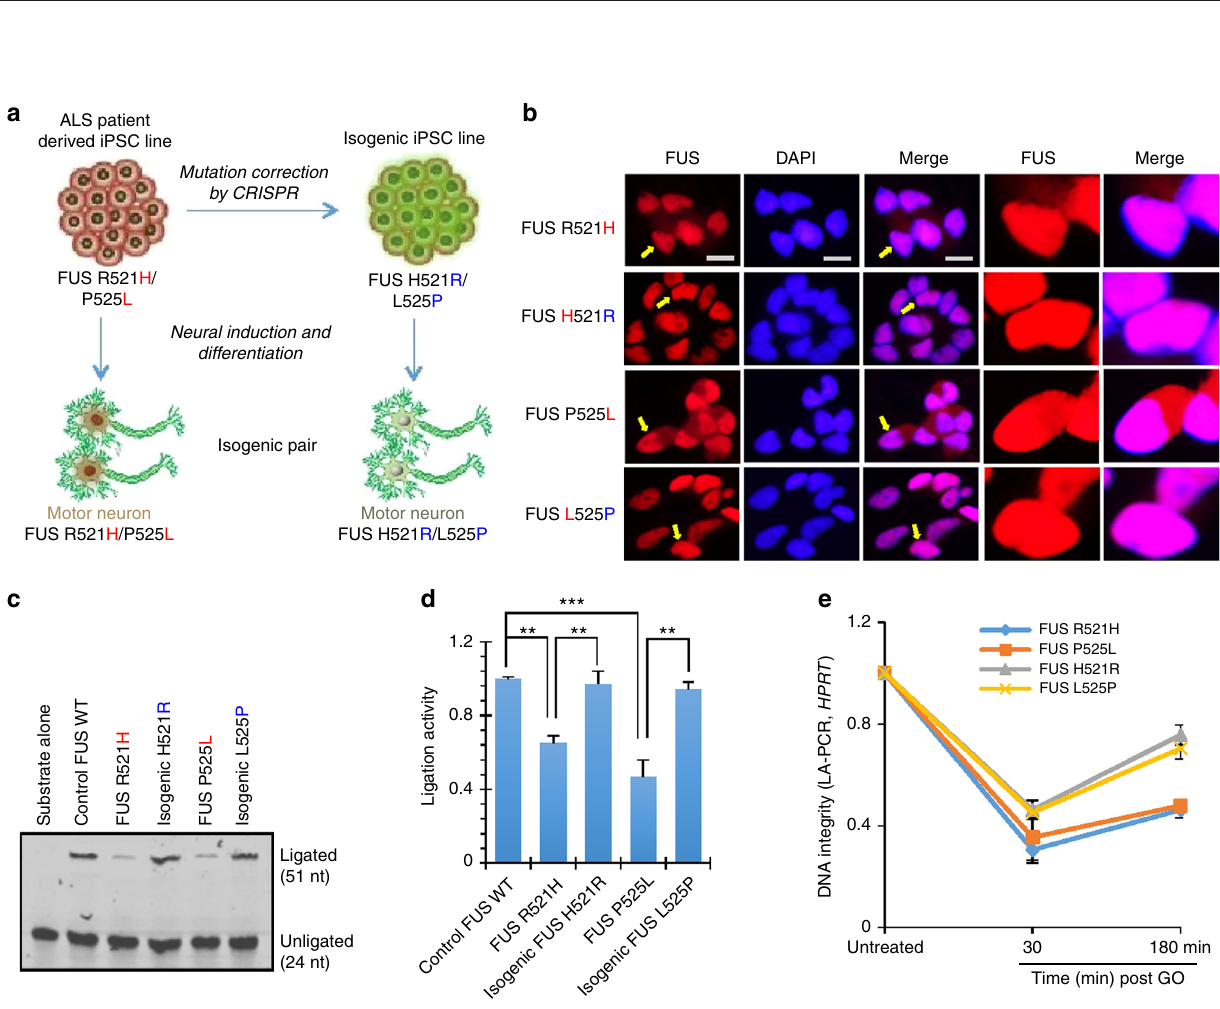
Fig. 5 Defective DNA repair in ALS patient-derived iPSC line. a The location of familial FUS mutations R521H and P525L indicated in FUS protein sequence. b , c IB of nuclear and cytosolic extracts isolated from ALS patient-derived fi broblasts, probed for FUS. H2AXII and β -actin were probed as loading control. Histogram shows quantitation of IB band intensity. The error bars are standard deviation of experiments performed in triplicate (* p < 0.05, two-tailed unpaired Student ’ s t -test). d , e Integrity of genomic DNA isolated from ALS patient-derived fi broblasts measured by long amplicon quantitative PCR (LA- PCR) analysis. 10.4 kb fragment including exons 2 – 5 of the hprt gene was ampli fi ed and separated in 1% agarose gel. The ampli fi ed DNA product was quanti fi ed using pico green fl uorescence. The error bars are standard deviation of experiments performed in triplicate (** p < 0.01, two-tailed unpaired Student ’ s t -test). f IF motor neurons for FUS to analyze its nucleus vs. cytosolic distribution. Nuclei stained with DAPI. Zoomed images on right showing FUS distribution in arrow indicated nuclear. Scale bar = 10 µ m. g , h LA-PCR-based DNA damage repair kinetic analysis. Genome DNA extracted from iPSC- derived motor neurons at indicated time points after release from exposure to GO (100 ng/ml) for 1 h. Ampli fi cation products analyzed by agarose gel electrophoresis or pico green-based quantitation as in Fig. 6d,e. The error bars are standard deviation of experiments performed in triplicate. i , j TUNEL analysis of motor neurons carrying FUS WT or FUS R521H or P525L mutation. Motor neurons differentiated from ALS patients derived iPSC lines were treated with H 2 O 2 (100 μ M for 3 h), and cells were subjected to TUNEL assay 24 h after the release from treatment. Scale bar = 50 µ m. Histogram shows quantitation of TUNEL-positive nuclei from 200 cells in total. The error bars are standard deviation (* p < 0.05, two-tailed unpaired Student ’ s t